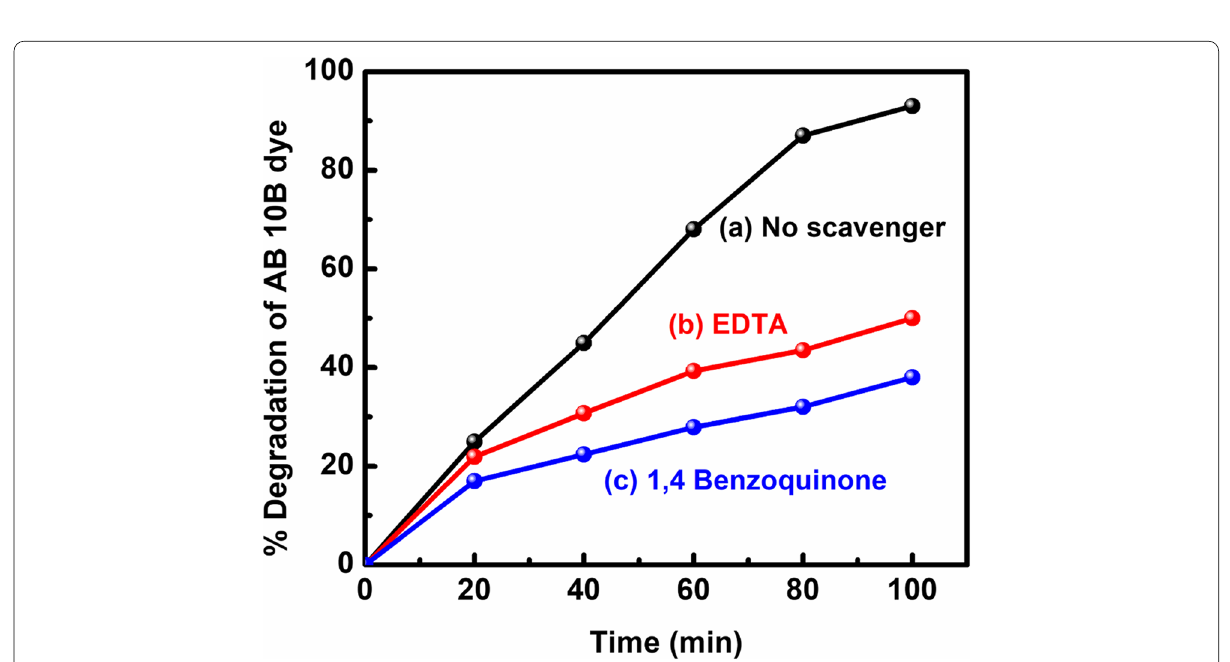
Fig. 16 Effect of e − hole and superoxide radicals ( • O 2 − ) scavenger on AB 10B